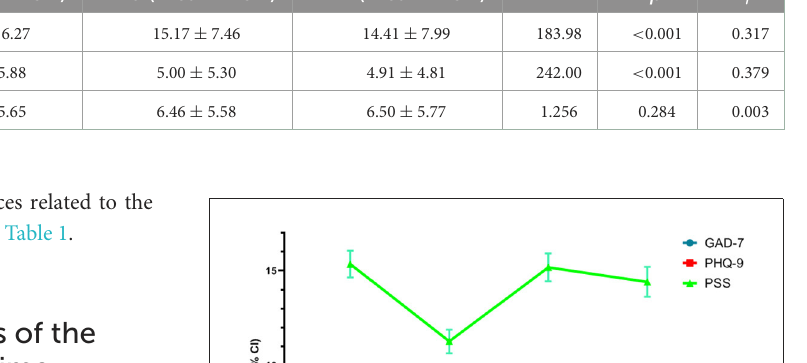
TABLE 2 Repeated-measures ANOVA: the disparity among the four time-points on the mean scores of PSS, GAD-7, and PHQ-9 ( n = 397). T1 (Mean ± SD) T2 (Mean ± SD) T3 (Mean ± SD) T4 (Mean ± SD) F p